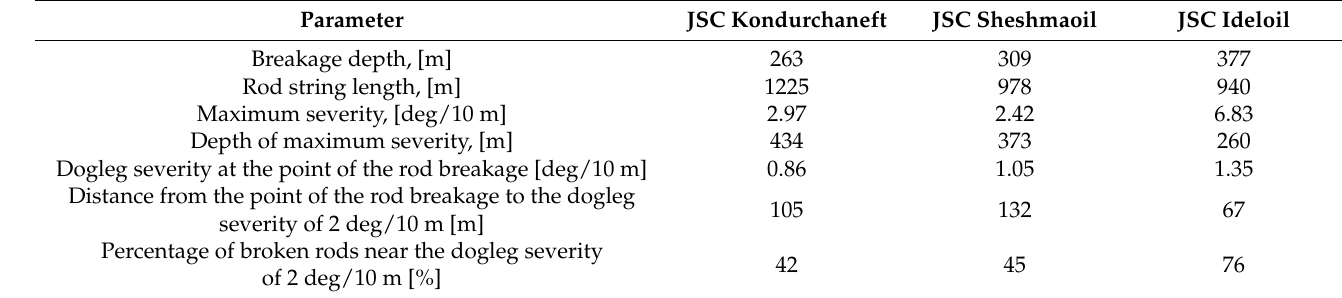
Table 1. The average values for the main parameters of wells where sucker-rod breakages occur.